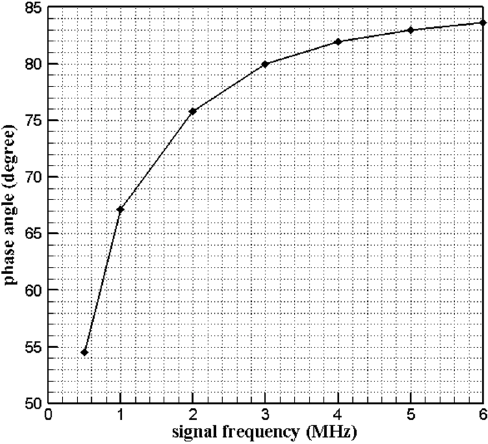
Figure 7. Sensor phase angle varies with excitation frequency.